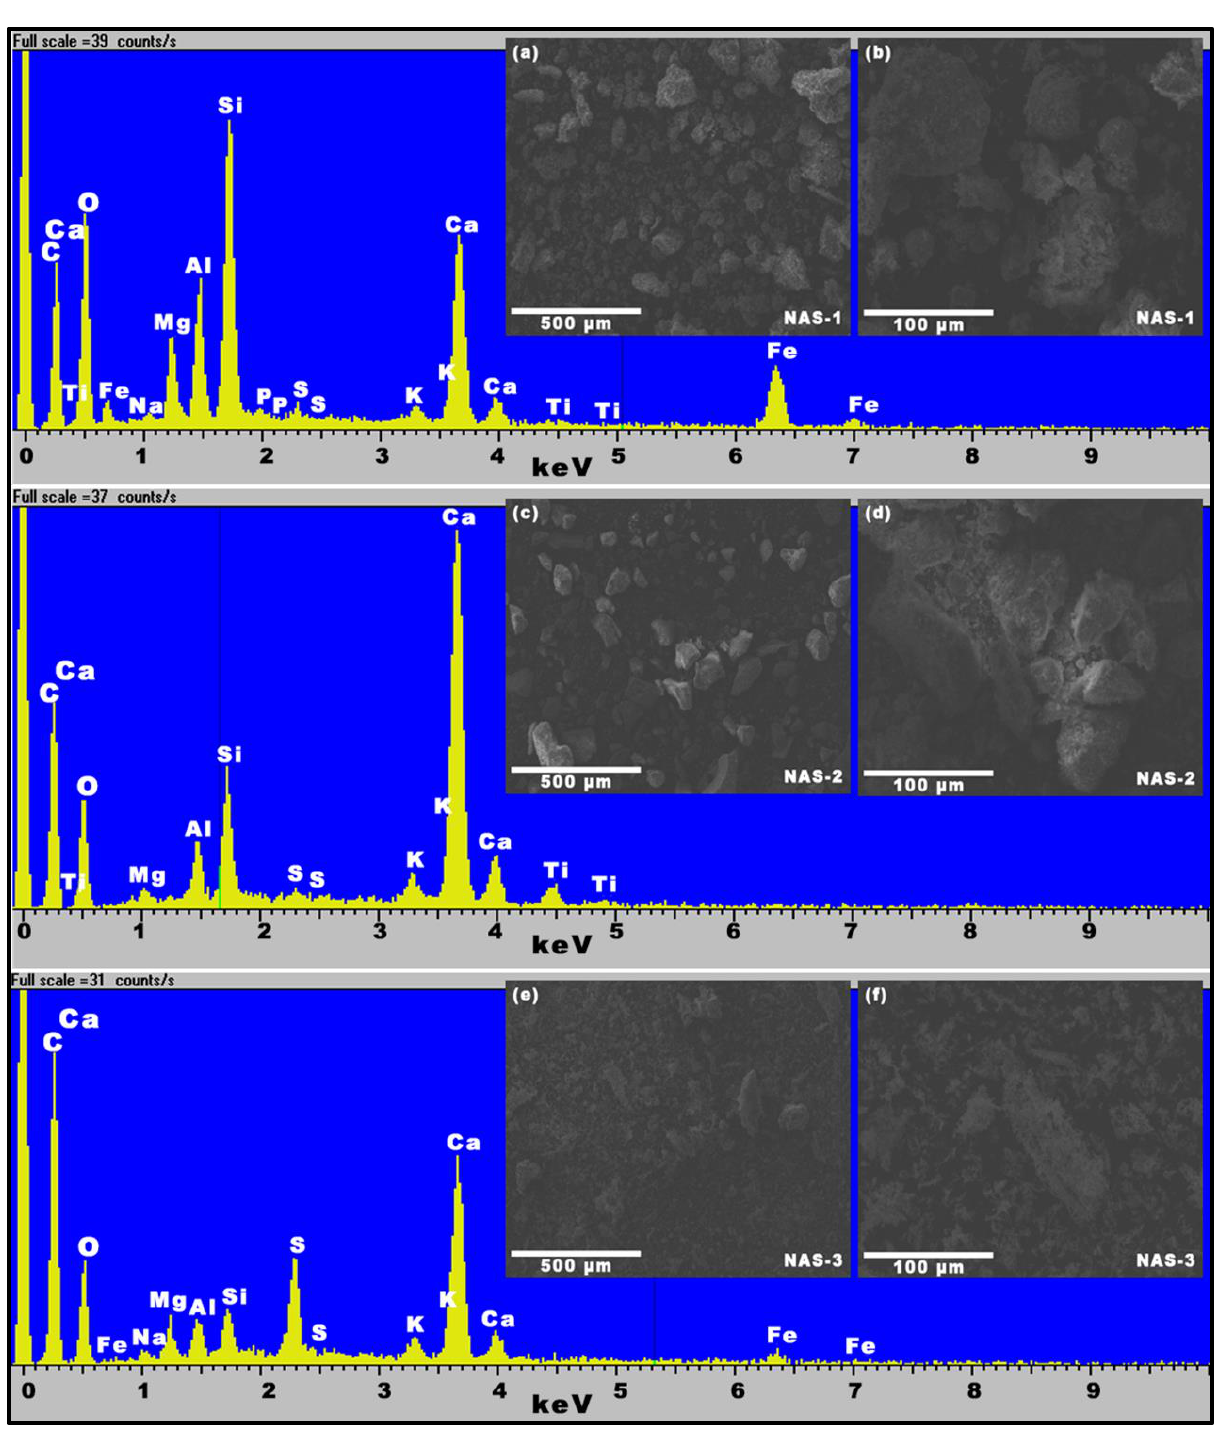
Figure 2. Representative ash EDS spectra of NAS-1, NAS-2, and NAS-3. Insets: SEM images of the ash of NAS-1 ( a , b ), NAS-2 ( c , d ), and NAS-3 ( e , f ).